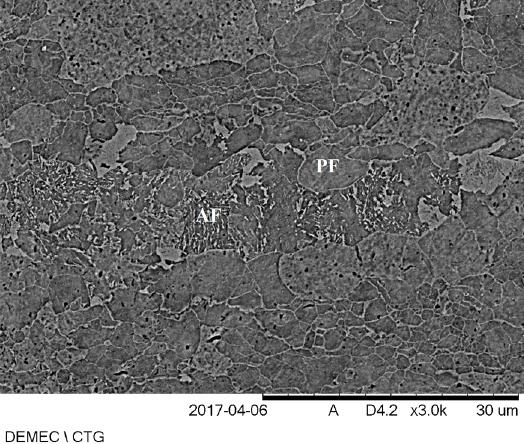
Figure 1. Microstructure of API 5L X80 steel showing acicular ferrite (AF) and polygonal ferrite (PF).